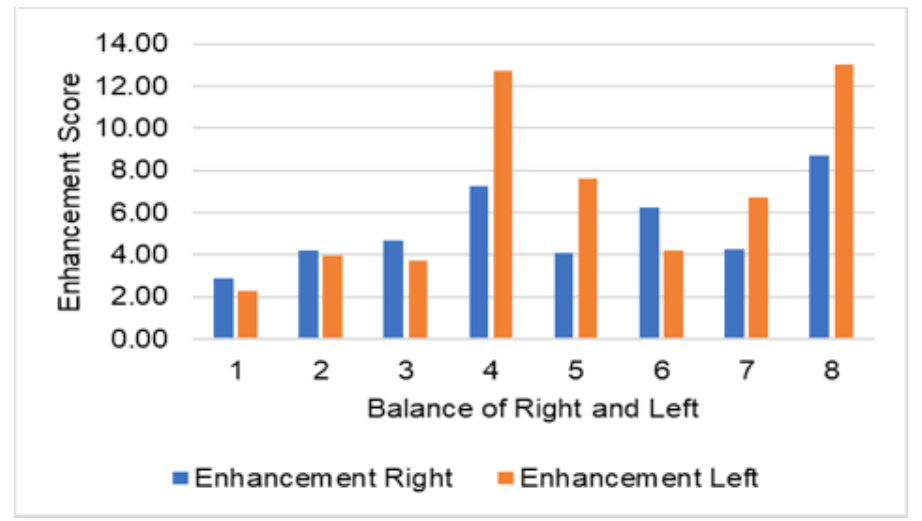
Figure 10. Enhancement of balance bosu ball exercise 18 years old